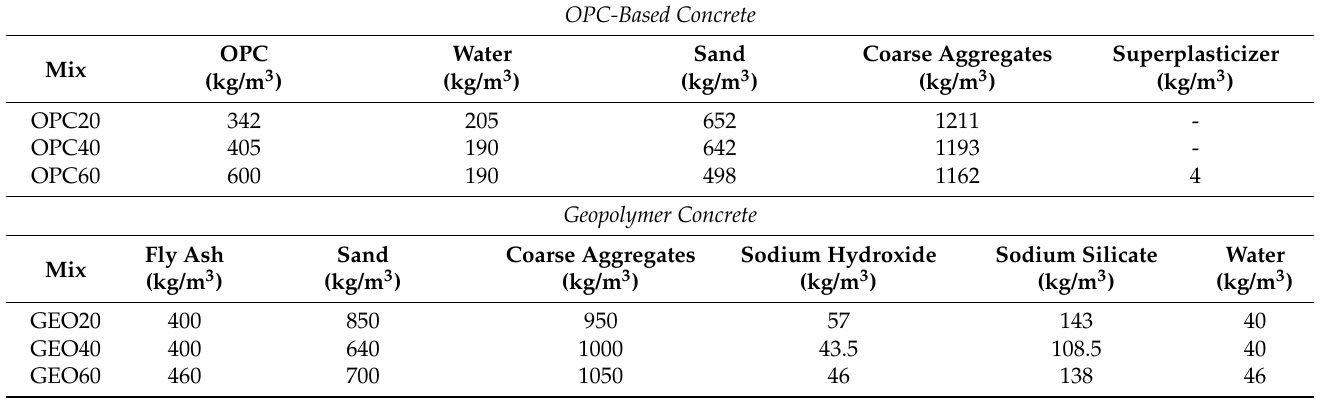
Figure 1. Mineralogy of the ( a ) OPC and ( b ) fly ash employed. Table 2. Concrete mix